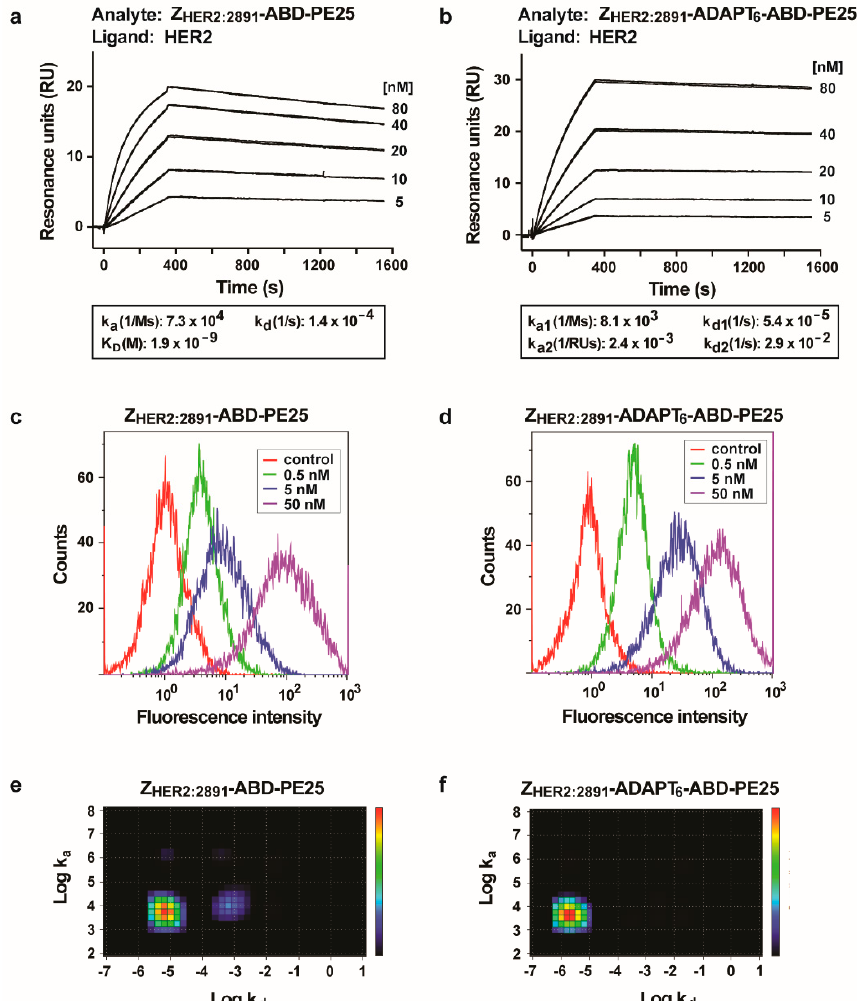
Figure 2. Analysis of the interaction with HER2. ( a , b ) Sensorgrams after analyses using a Biacore real-time biosensor of the interaction of the fusion toxins with HER2. Dilution series of the fusion toxins were injected sequentially over a surface with immobilized HER2. Each concentration was injected twice, and each panel is an overlay of both repeats of all concentrations. The injected concentrations are indicated to the right of each panel. SKOV3 cells were stained with di ff erent concentrations of the fusion toxins, followed by staining with fluorescently labeled human serum albumin (HSA) and were analyzed by flow cytometry ( c , d ). The concentration of the fusion toxins used for staining is indicated in the legend. Each panel is an overlay of the plots obtained for all concentrations for each fusion toxin. The controls are non-stained cells. Further, the fusion toxins were radiolabeled with 99m Tc and incubated with SKOV3 cells and cell bound radioactivity was recorded as a function of time in a Ligandtracer instrument. The obtained curves were analyzed by Tracedrawer software and the resulting Interaction Maps are presented in ( e , f ).